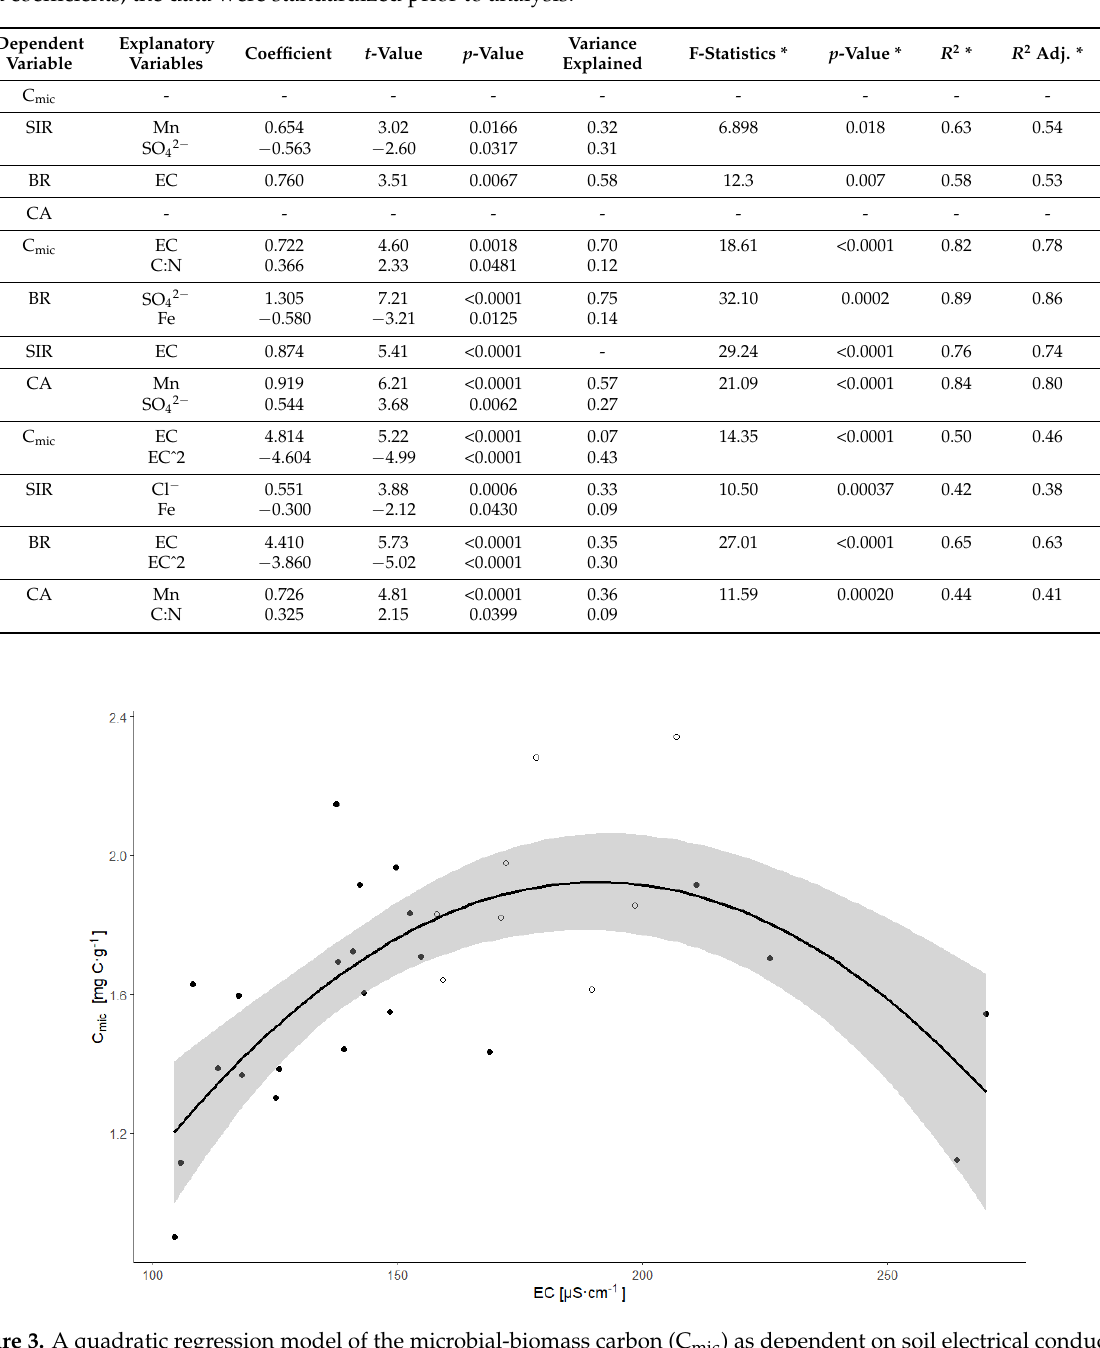
Figure 4. Linear regression models of substrate-induced respiration (SIR) as dependent on chlo- ride contents at Placek B site, separately for the plots with different levels of C:N ( full symbols + full line for C:N range 4.5–6.9; hollow symbols + dashed line for C:N range 11.2–12.7). In general, the availability of Mn had merely positive effects on soil microbial char- acteristics and was consistently the main explanatory variable for CA at both Placek A and Placek B sites, contributing to 36–63% of the total variance (Tables 1 and 2); no valid model for CA was found at Bedrich site. In contrast, the available Fe contents had negative secondary effects on microbial characteristics, namely on C mic at Placek A site in 2019 (Ta- ble 1) and on BR at Placek A and Placek B sites in 2020 (Table 2). Overall, the Fe and Mn contents were significantly negatively correlated across the sites both the years (Figure